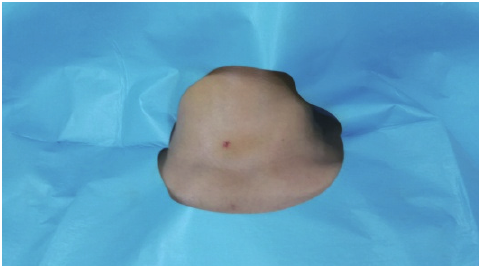
Figure 9 Sterile towel on the operative field.